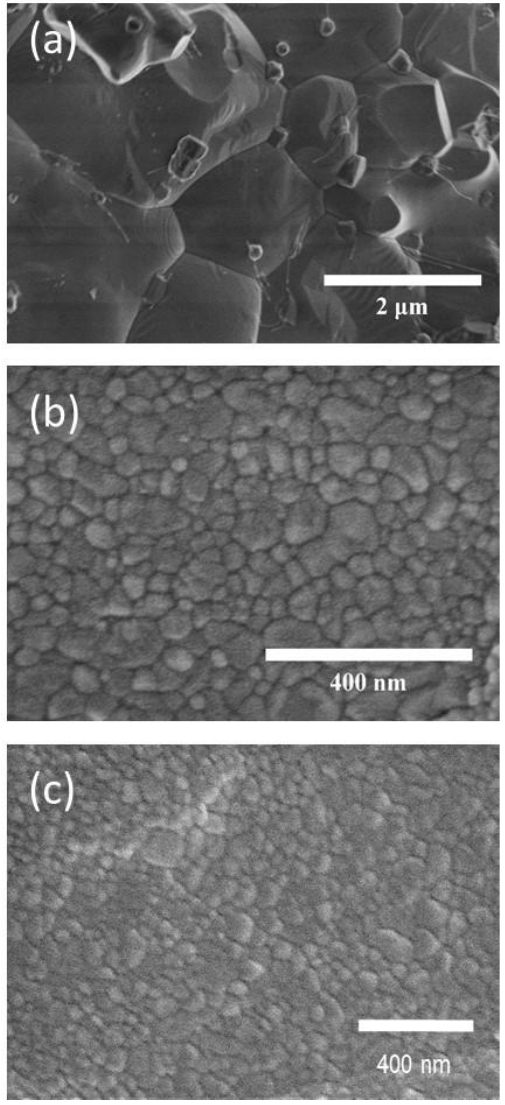
Figure 3. Scanning electron microscopy micrographs of pellets prepared by ( a ) SSR, and mechanosynthesis followed by sintering using ( b ) SPS and ( c ) FS.